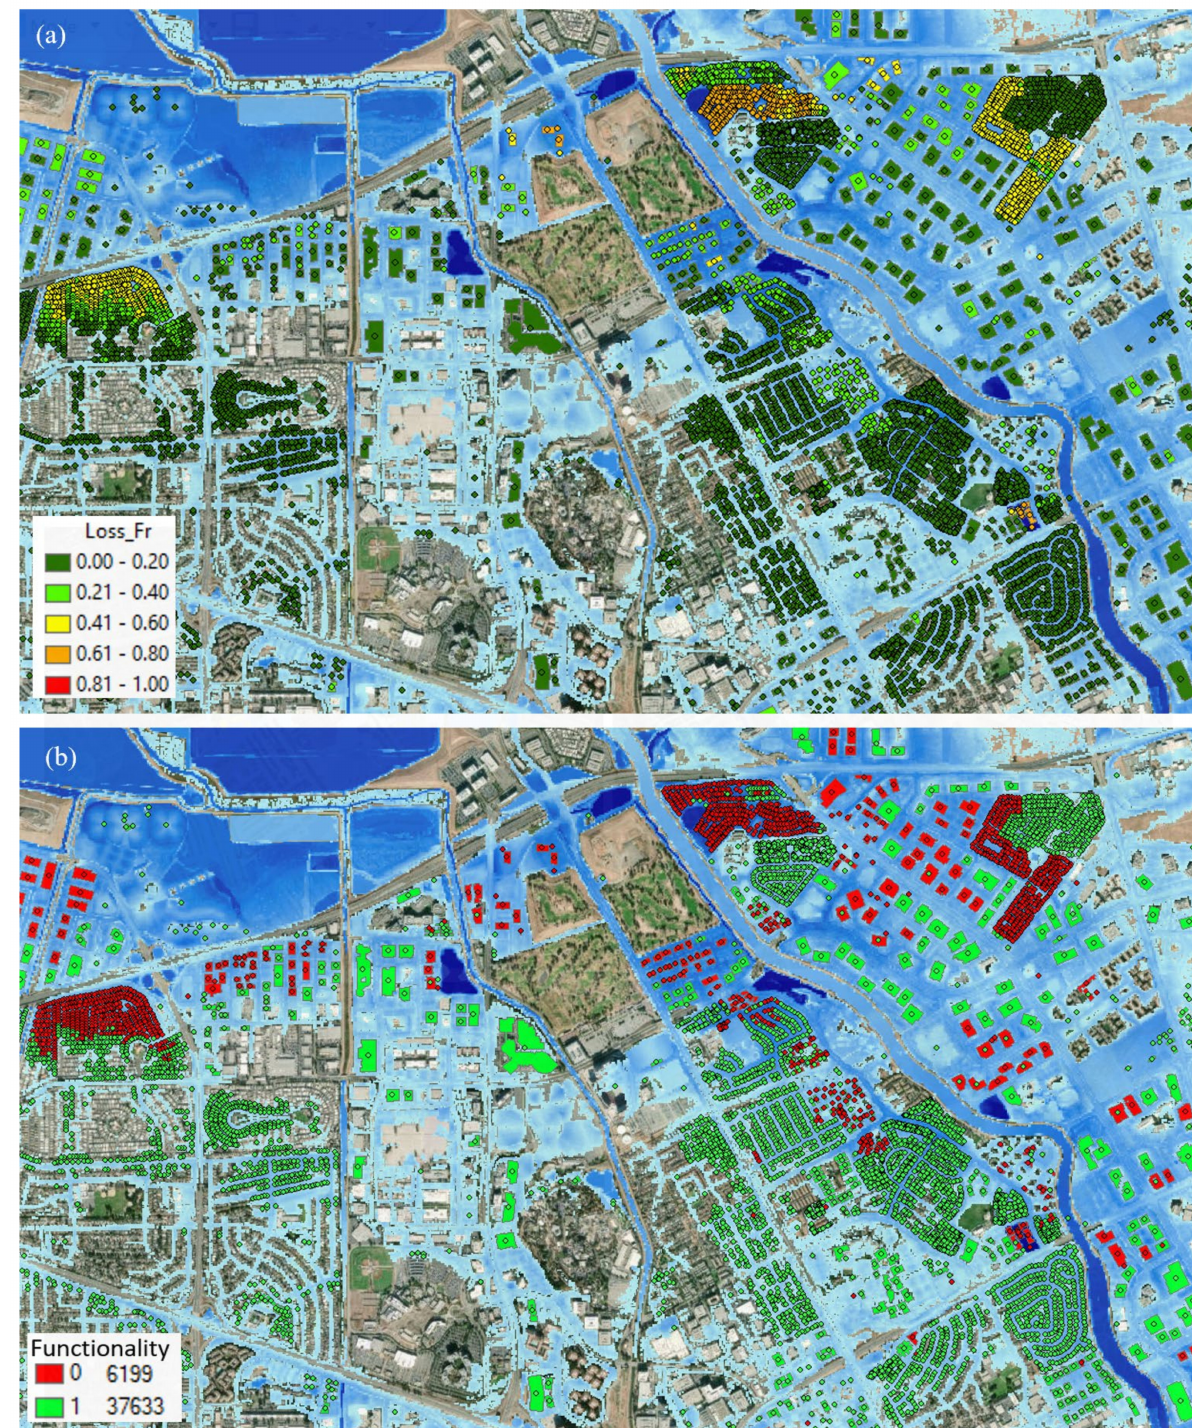
Figure 15. Color-coded maps for one of the flooded locations: ( a ) Color-coded buildings based on the buildings’ functionality after the flooding event (red: unfunctional, green: functional); ( b ) color-coded buildings based on the amount calculated flood